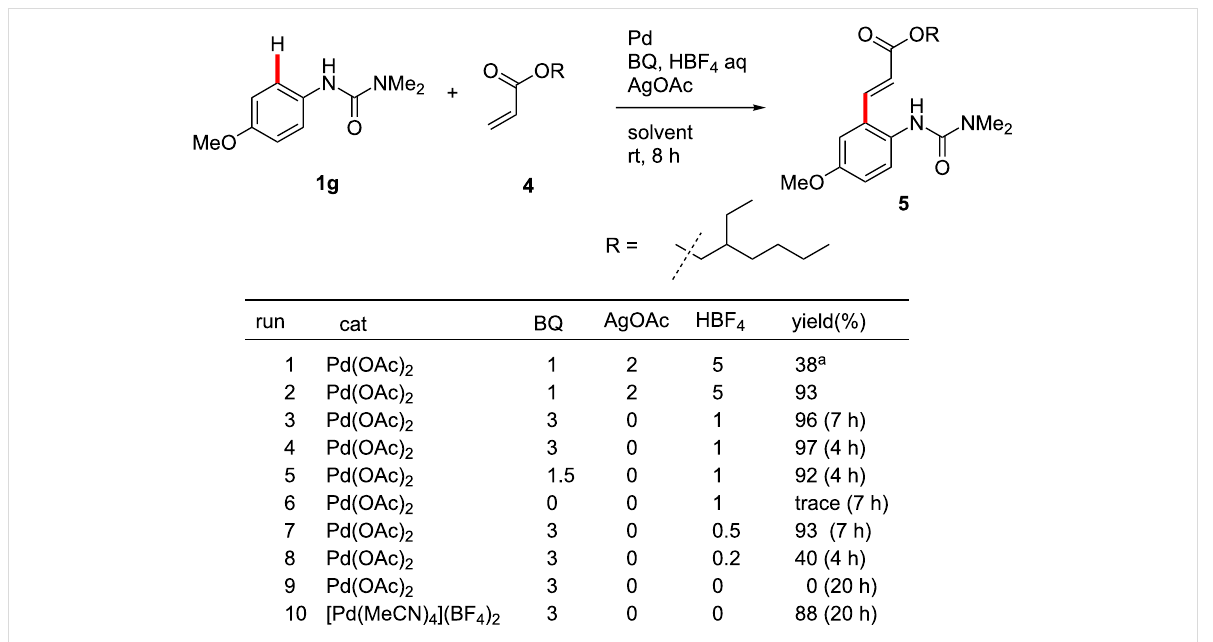
metric silver salts in addition to